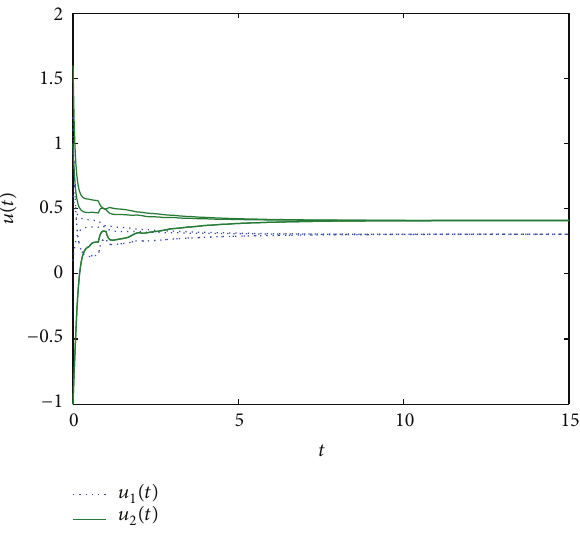
Figure 1: Time responses of the state variables 𝑢(𝑡) with different initial values in Example